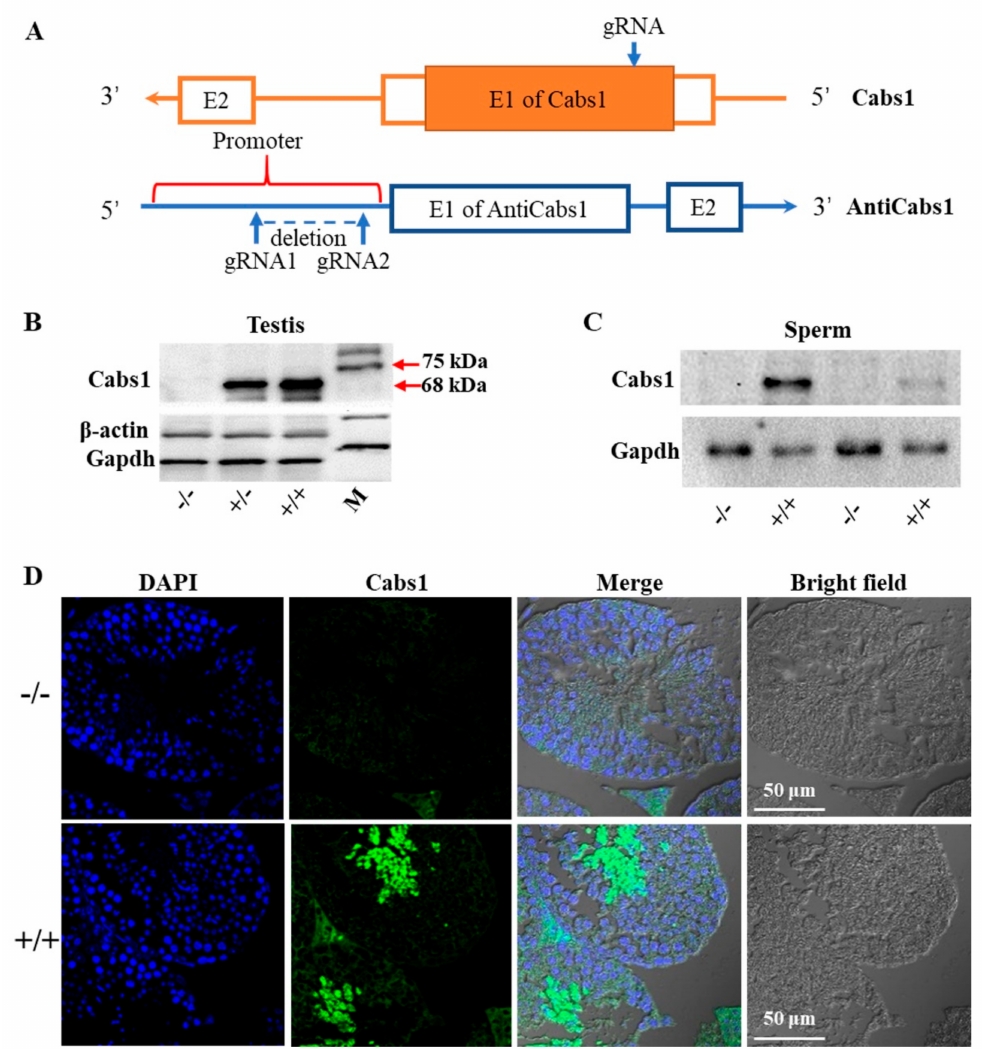
and male fertility (Figure S3E,F) all showed normal phenotypes. Hence, Cabs1 , rather than AntiCabs1 , exerted an organizational role in the annulus for the proper architecture of the tail.